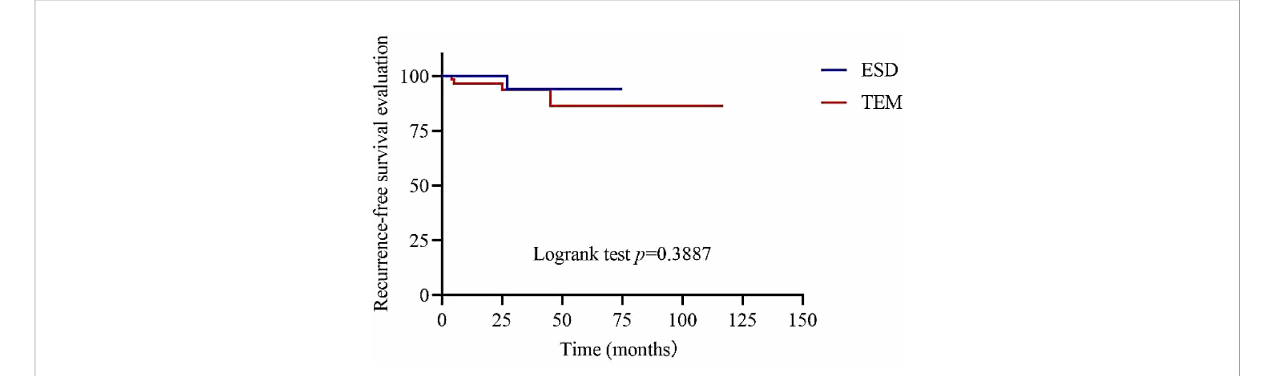
FIGURE 2 Recurrence-free survival time of patients with rectal NETs ≤ 2 cm between ESD and TEM groups.